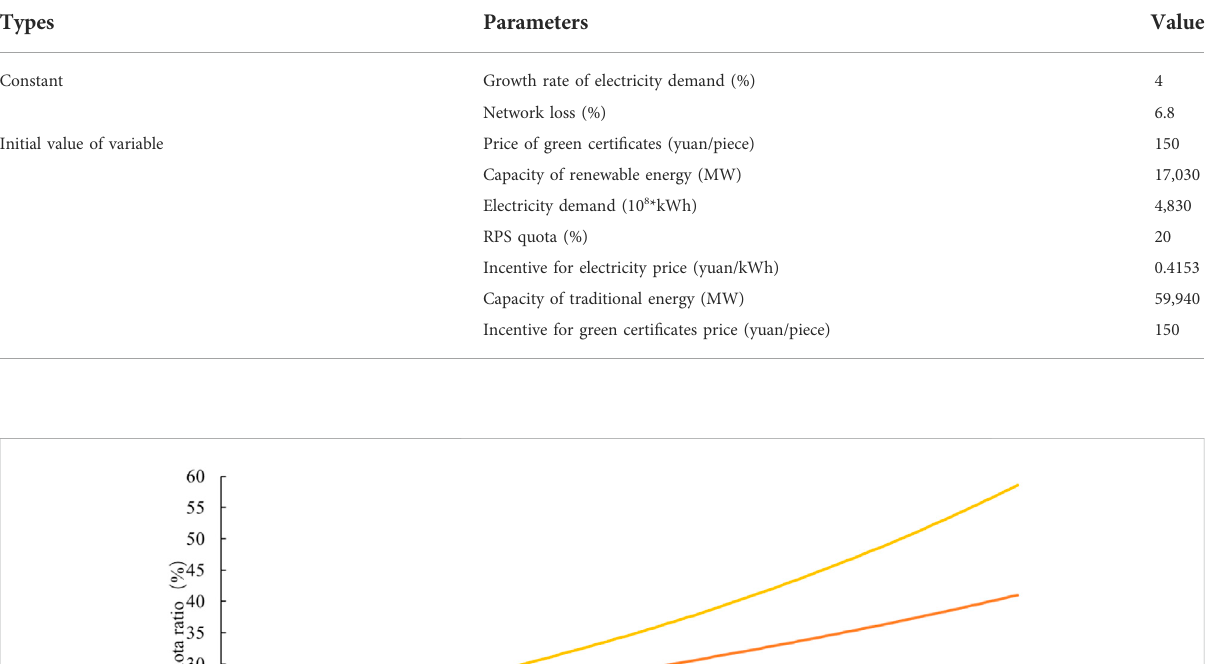
TABLE 3 Speci fi cation of key parameters in the simulation.